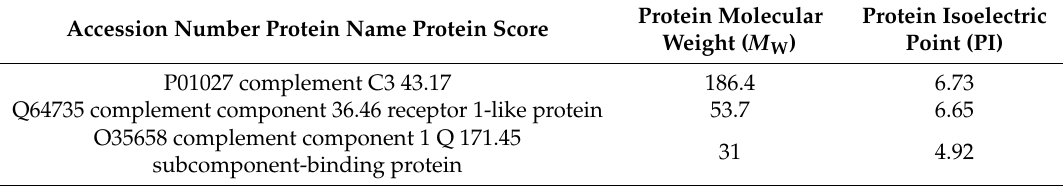
Table 1. List of complement component proteins identified using LC–MS/MS analysis.